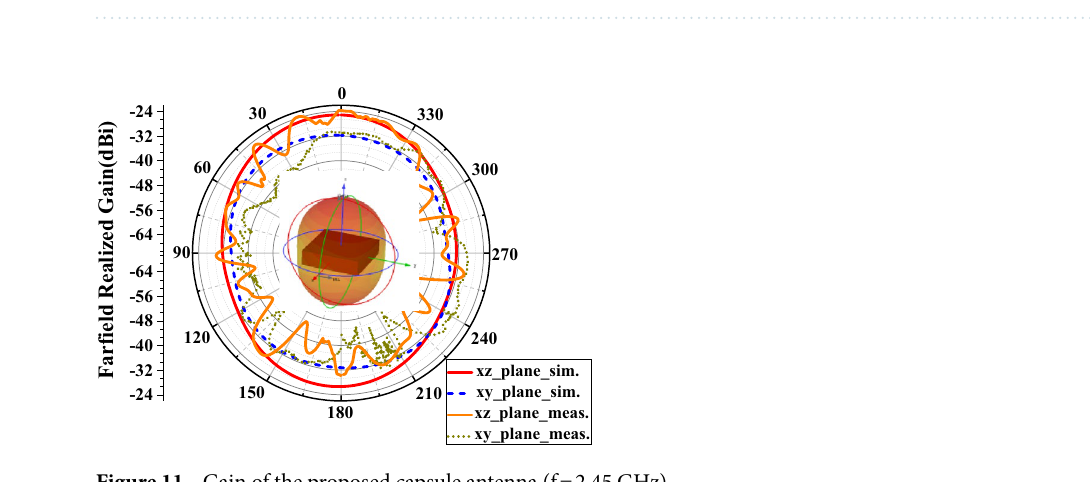
Figure 10. the effects of implantation depth on the antenna performance (radiation pattern).